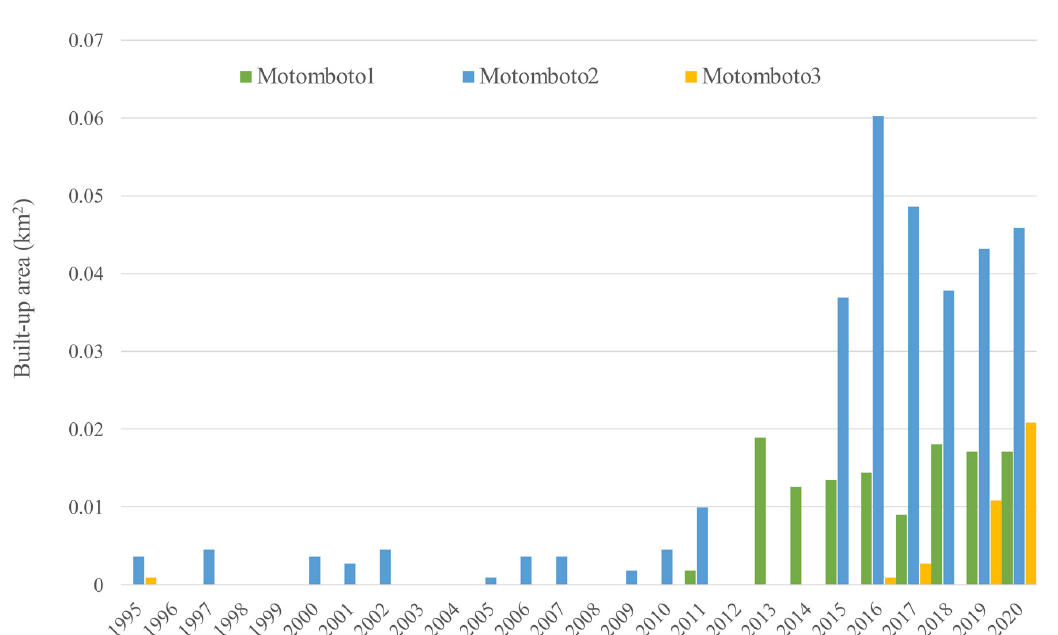
Figure 6. Built-up areas by ASGM